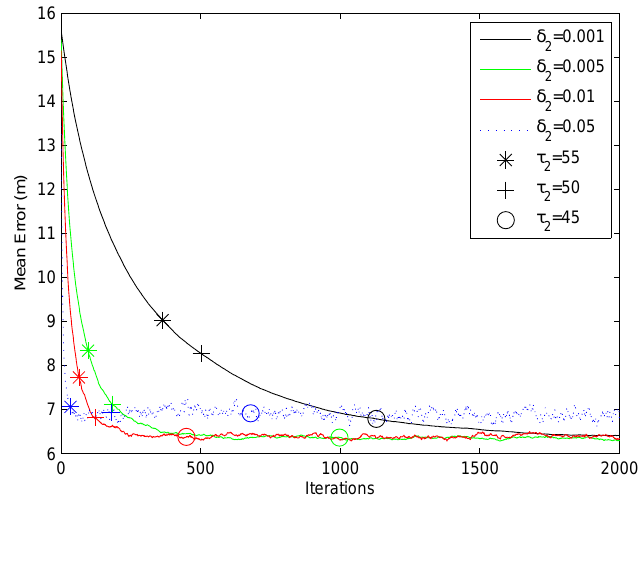
Figure 6. The evolution of location estimation error for the observed sensor with different (cid:28) and (cid:14) . 2 2